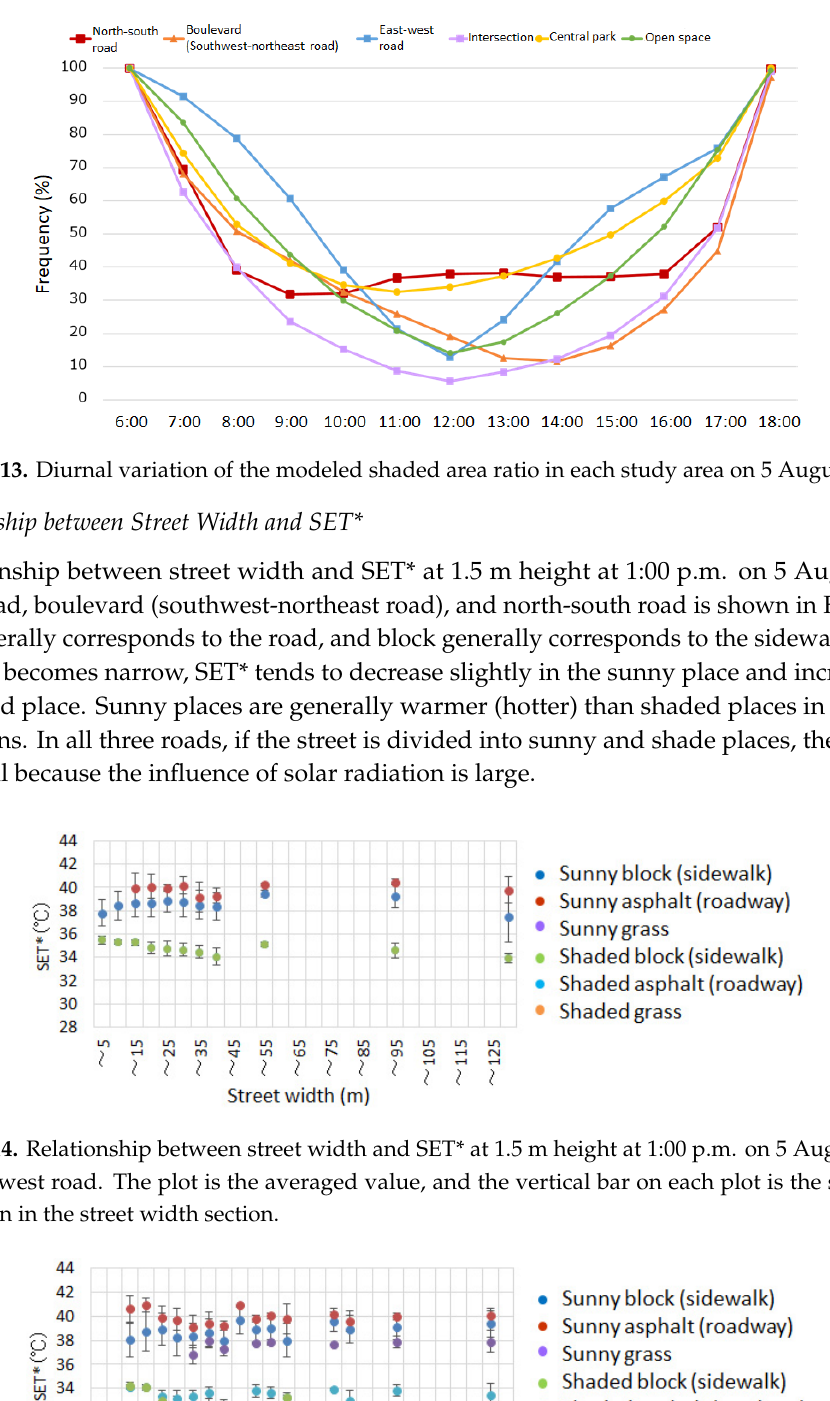
Figure 12. Diurnal variation of the spatial distribution frequency of modeled SET* at 1.5 m height in each study area on 5 August 2019.